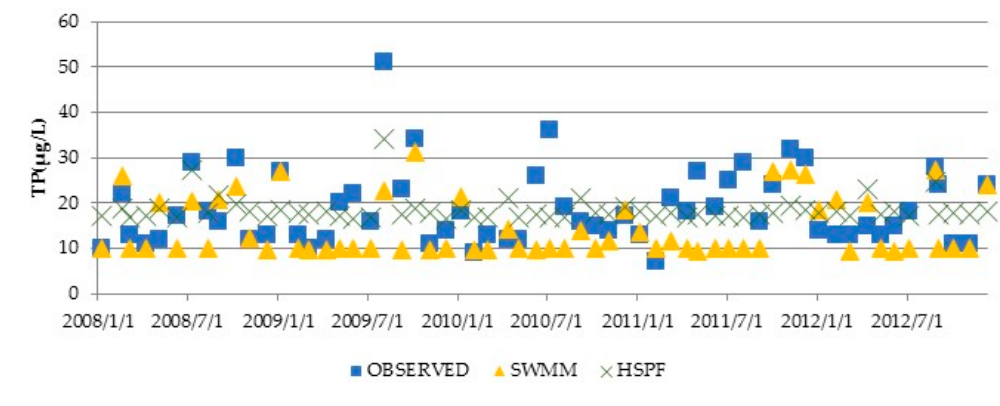
Figure 7. Validation of the TP simulation for the HSPF model and SWMM.